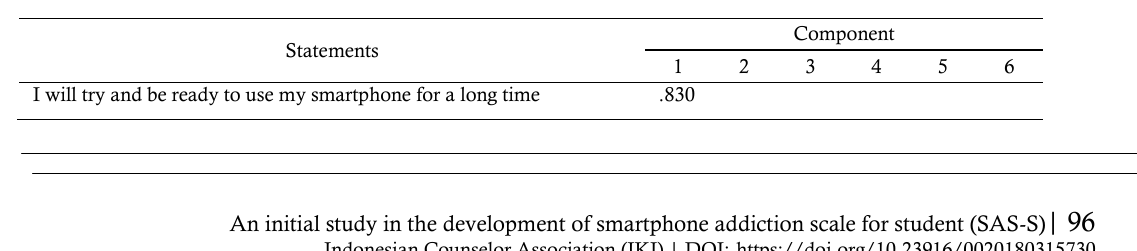
Table 4. Rotaed Component